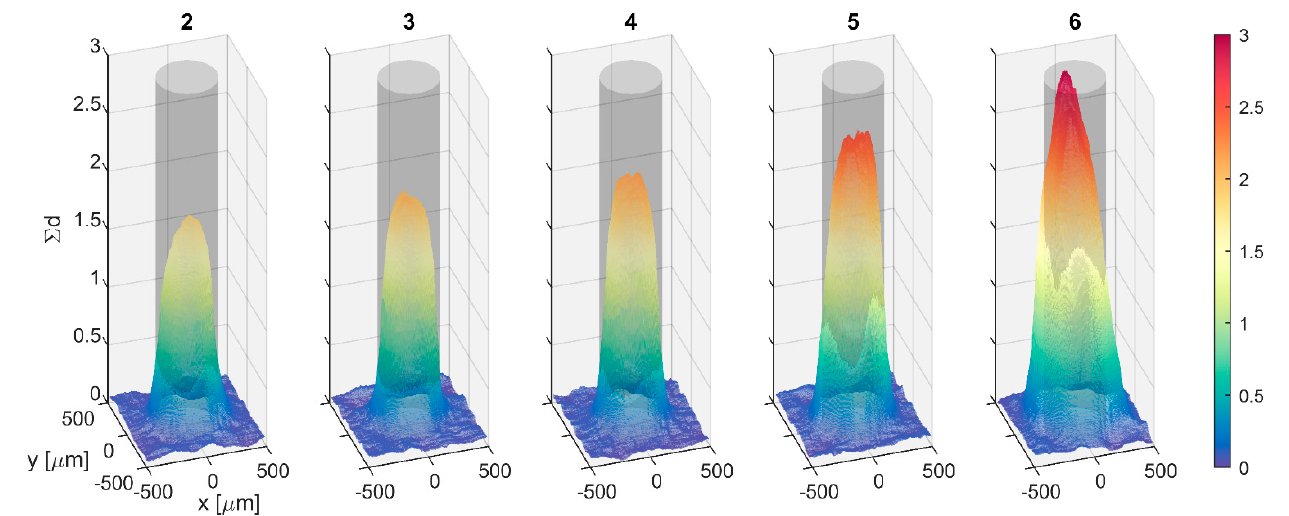
Figure 19. Representative dot from each 500 μ m pattern measured at BT2 shows progressive mounding and trend toward conical shape with increased number of print layers. Transparent cylinder is target geometry.